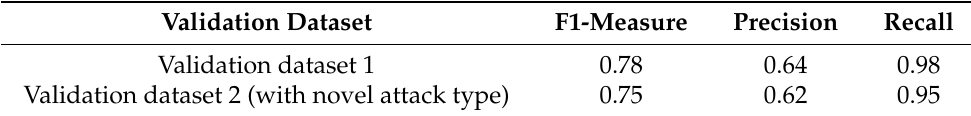
Table 5. Performance of the CNN on different validation